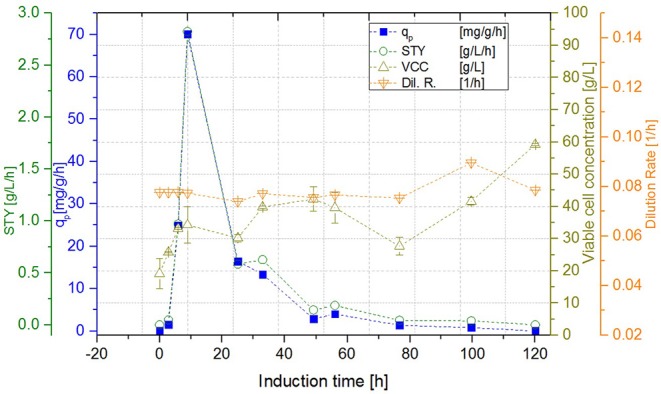
Cascade 2 operated at a dilution rate of Dges = 0.08 ± 0.004 h−1 (pH = 6.7, TR1 = 35°C, TR2 = 31.5°C).